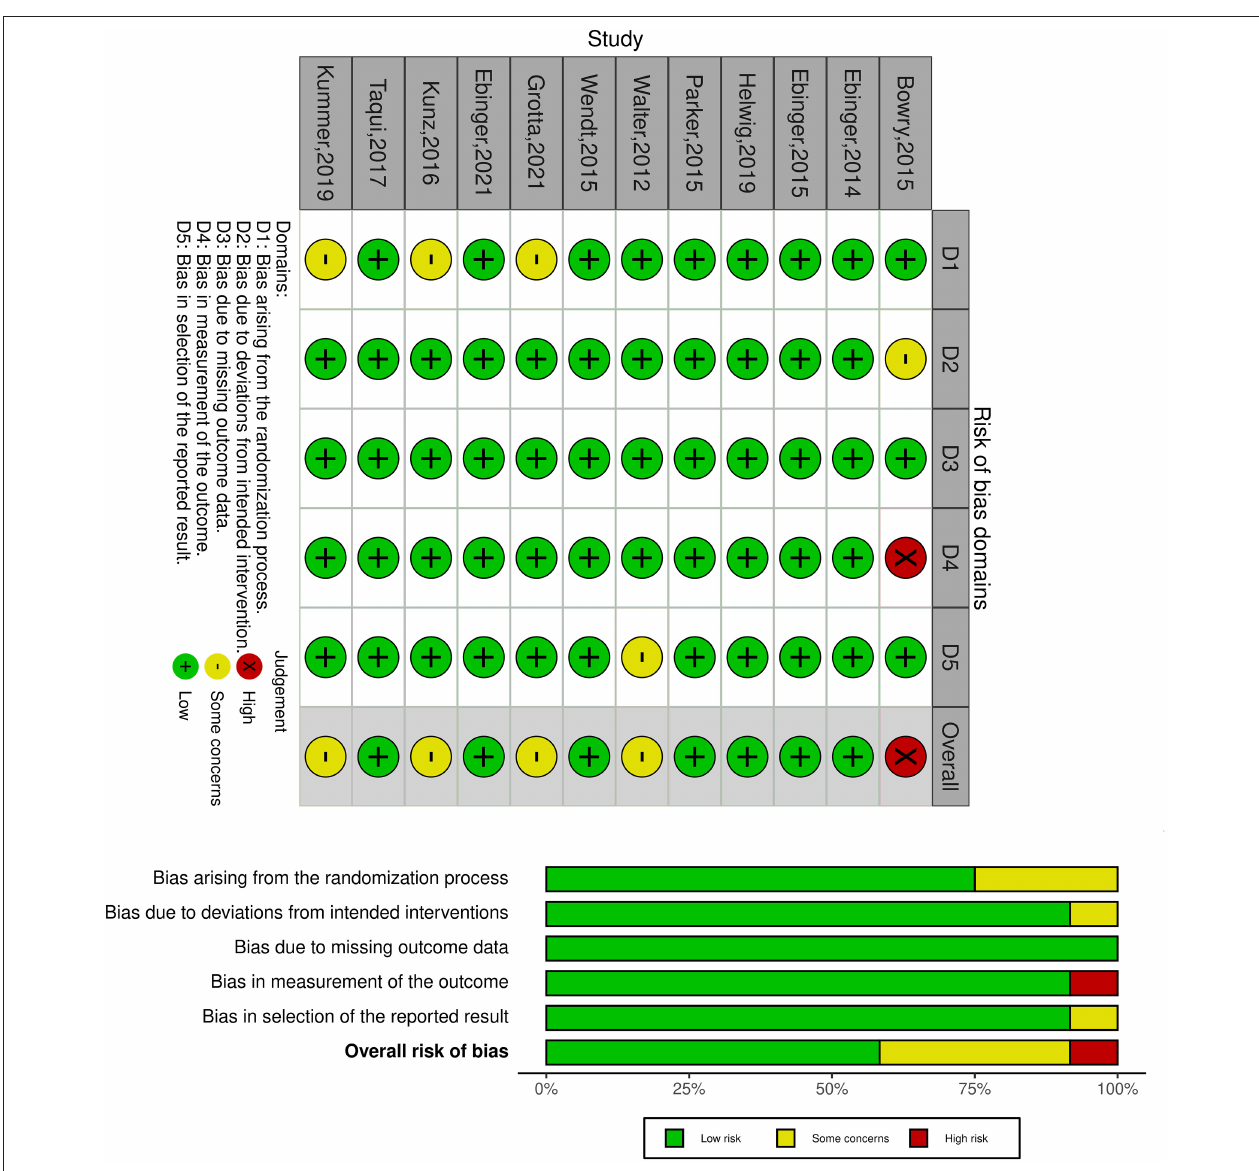
FIGURE 2 | Bias risk assessment for inclusion in the